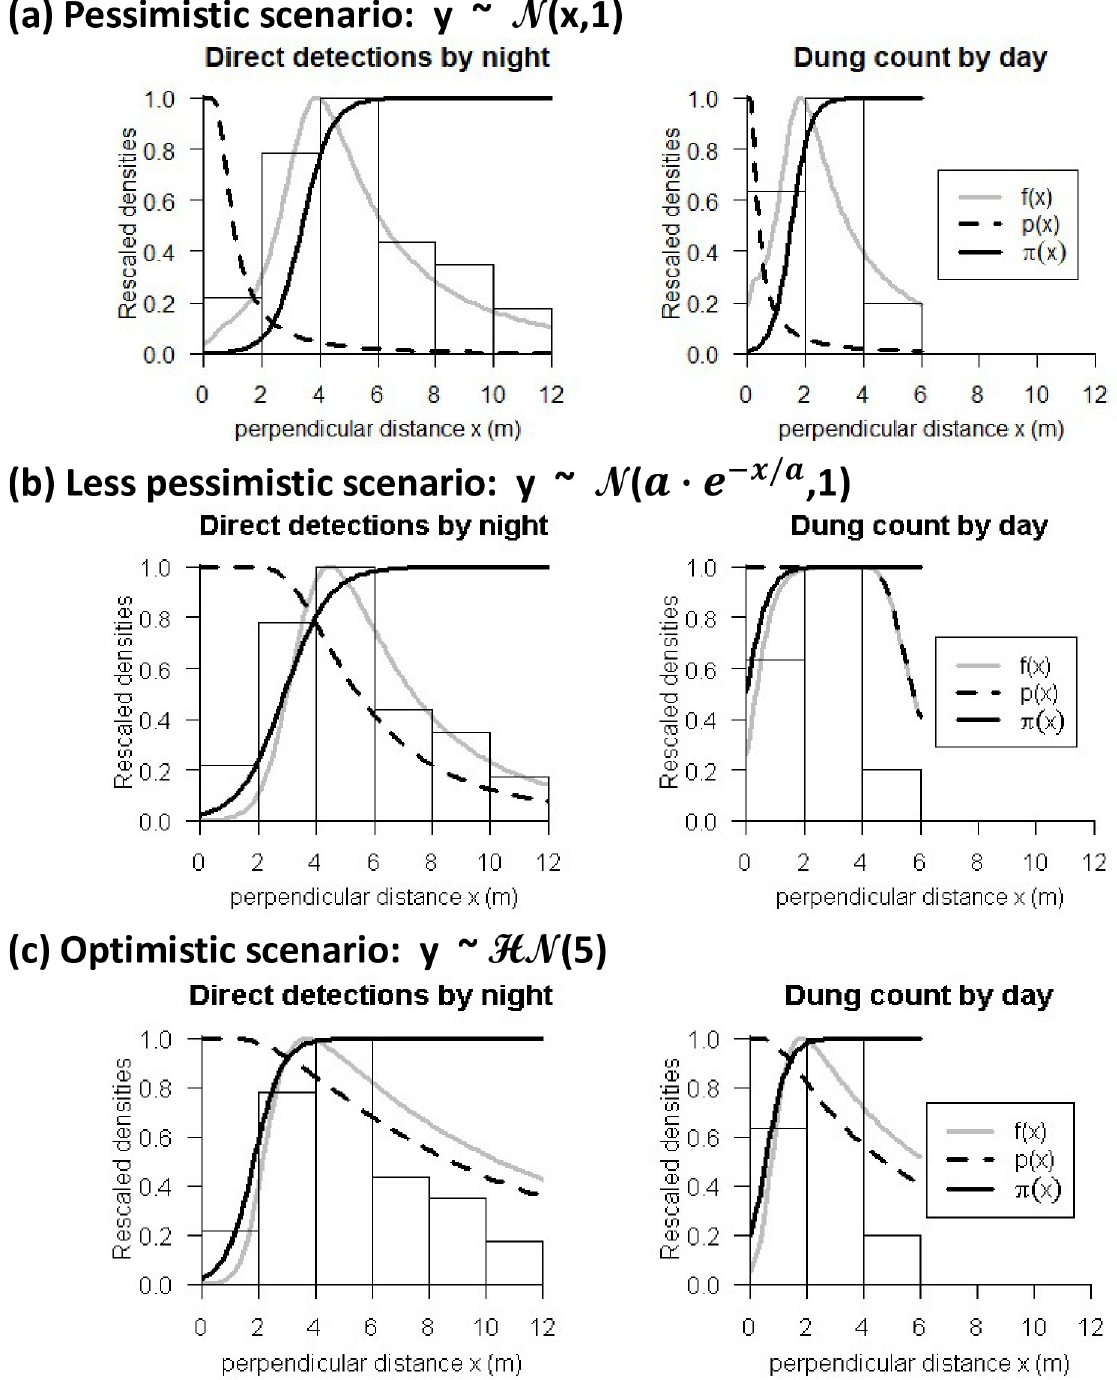
Fig 3. Estimated detection probability p (x), behavioural response π (x), and expected density of sightings f (x), as a function of the perpendicular distance x , for blue duikers in the Lomako study area, with three ways to simulate the forward distance y. The binned detection data are provided for comparison